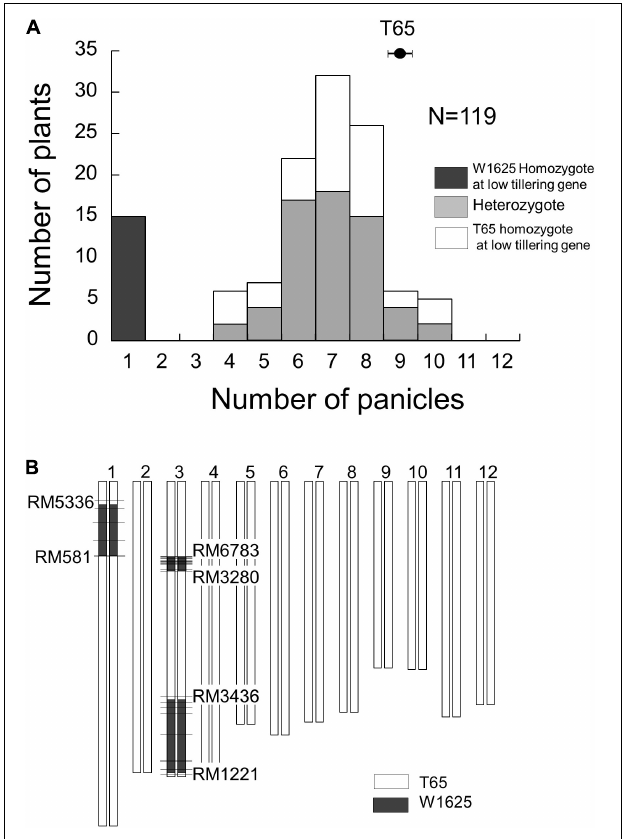
FIGURE 3 | Frequency distribution of panicle number (A) and graphical genotype of low-tillering line (B) in BC 4 F 5 population derived from a cross between T65 and W1625. Black, gray, and white colors in (A) indicate W1625 homozygote, heterozygote, and T65 homozygote for low-tillering locus through scored based on segregation of phenotypes in the next generation. The horizontal bars in (B) show the location of polymorphic SSR markers.